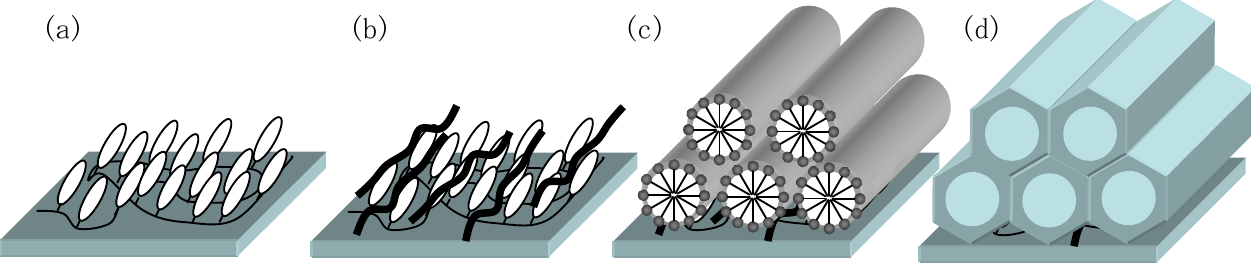
Figure 14. Schematic procedure of photoorientation of a